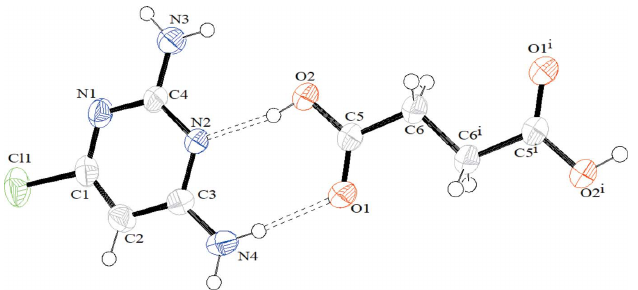
Figure 1 The molecular structure of the title compound showing 50% displace- ment ellipsoids and hydrogen bonds indicated by dashed lines. Symmetry code: (i) 2 (cid:3) x , 3 (cid:3) y , 1 (cid:3) z .